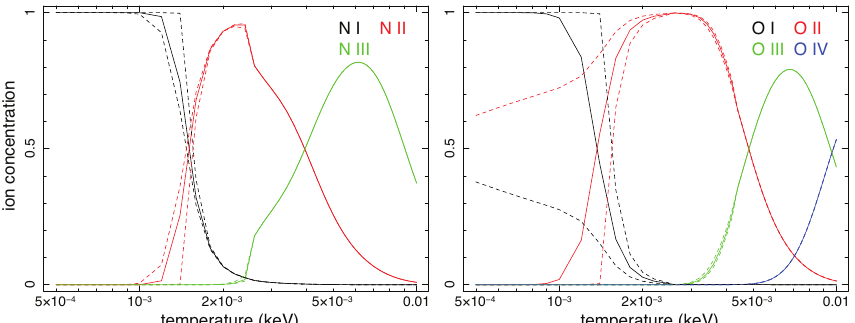
Figure 3. Charge state distributions of N ( left ) and O ( right ) as a function of equilibrium temperature for the CIE plasma, calculated with SPEX version 3.06.01. The dashed lines show the calculations when the charge exchange recombination rates are changed by 50%, while the other ionization and recombination data are kept